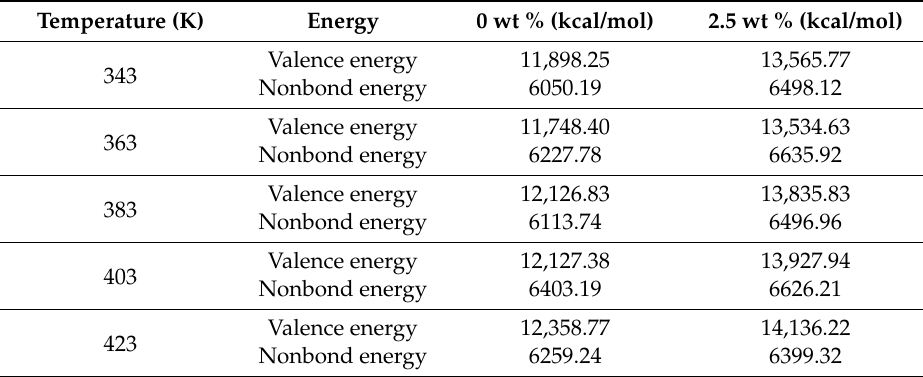
Table 4. Energy values of bonding and nonbonding interactions at different temperatures. Temperature